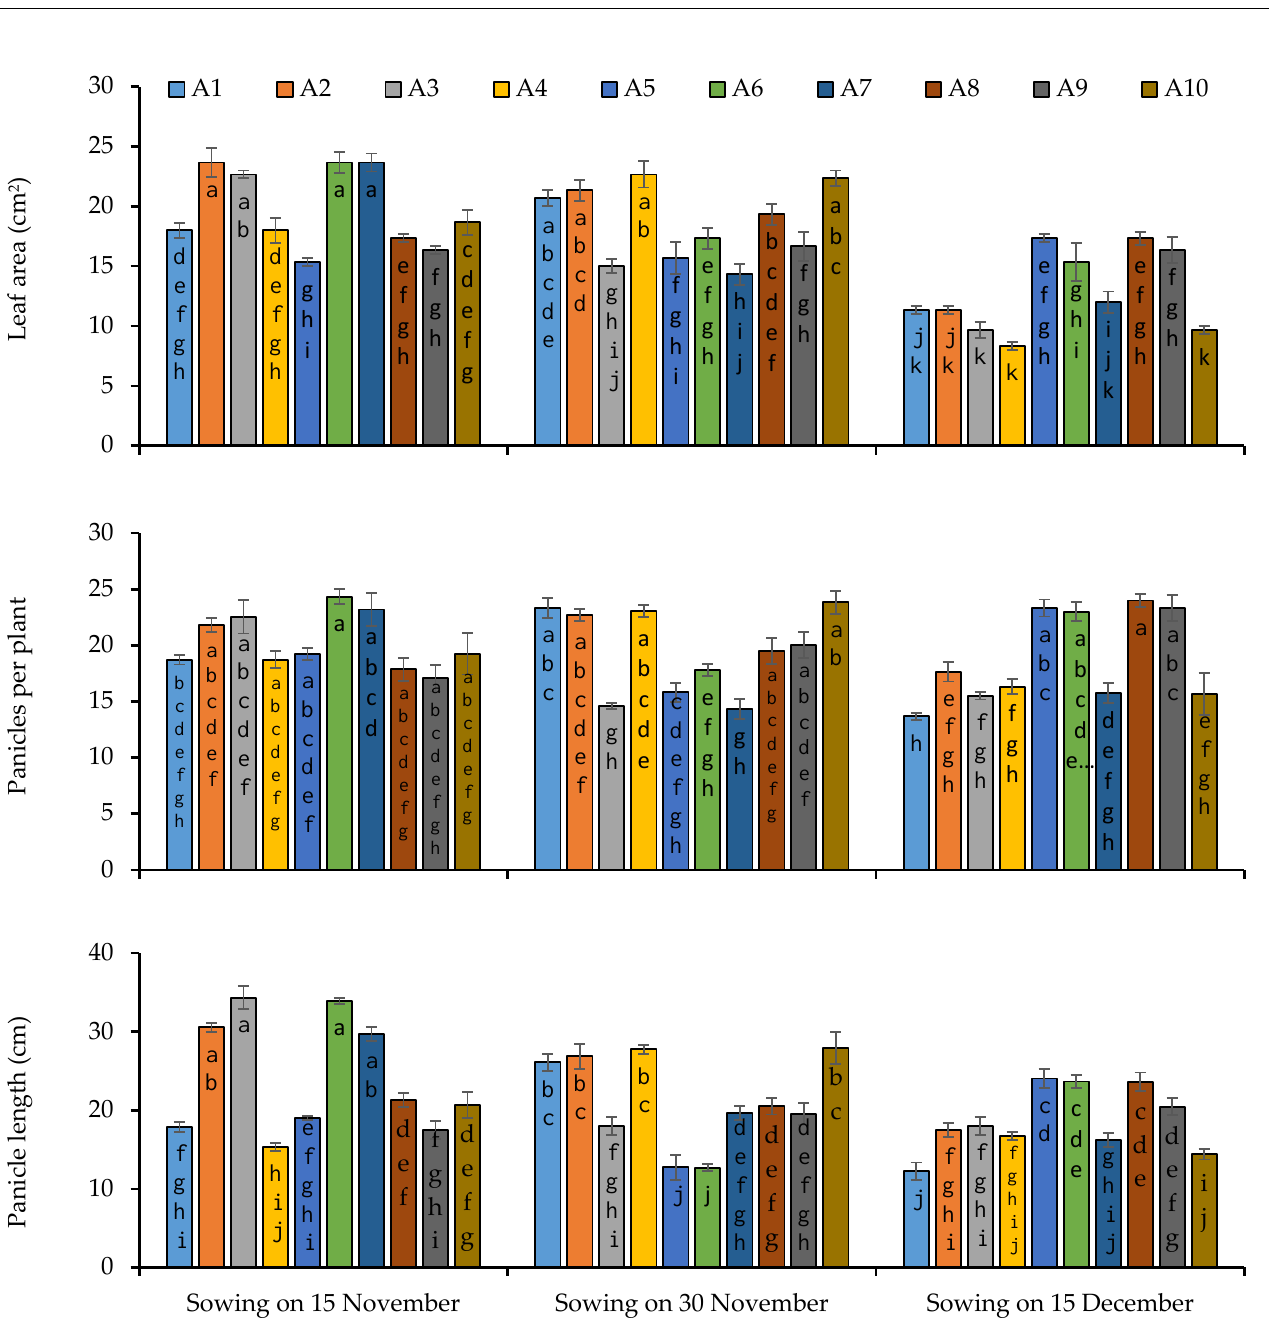
Figure 5. Leaf area (single leaf), number of panicles and main panicle length of quinoa lines grown under varying sowing dates. Bars sharing the same alphabet did not differ significantly at p < 0.05. Small alphabets (a, b, c. etc.) are used to express the statistically significant difference. Biological yield was not statistically influenced by the sowing dates (Table S1); how- ever, the first sowing was comparatively better for biological yield. Among the lines, line 6 produced the highest biological yield (7446.2 kg ha − 1 ) followed by lines 10 (7029.9 kg ha −1 ) and 4 (6964.9 kg −1 ), respectively. In the case of the interactive effect of sowing dates and lines, line 3 and 6 under first sowing, lines 10 and 4 under second sowing and line 5 under the third sowing date produced more biological yield, respectively, as compared to other genotypes (Figure 6). Significant variations were recorded within the quinoa line regarding grain yield and 1000-grain weight, and even sowing dates significantly influ- enced these parameters. The interaction of sowing dates and quinoa line was noted as